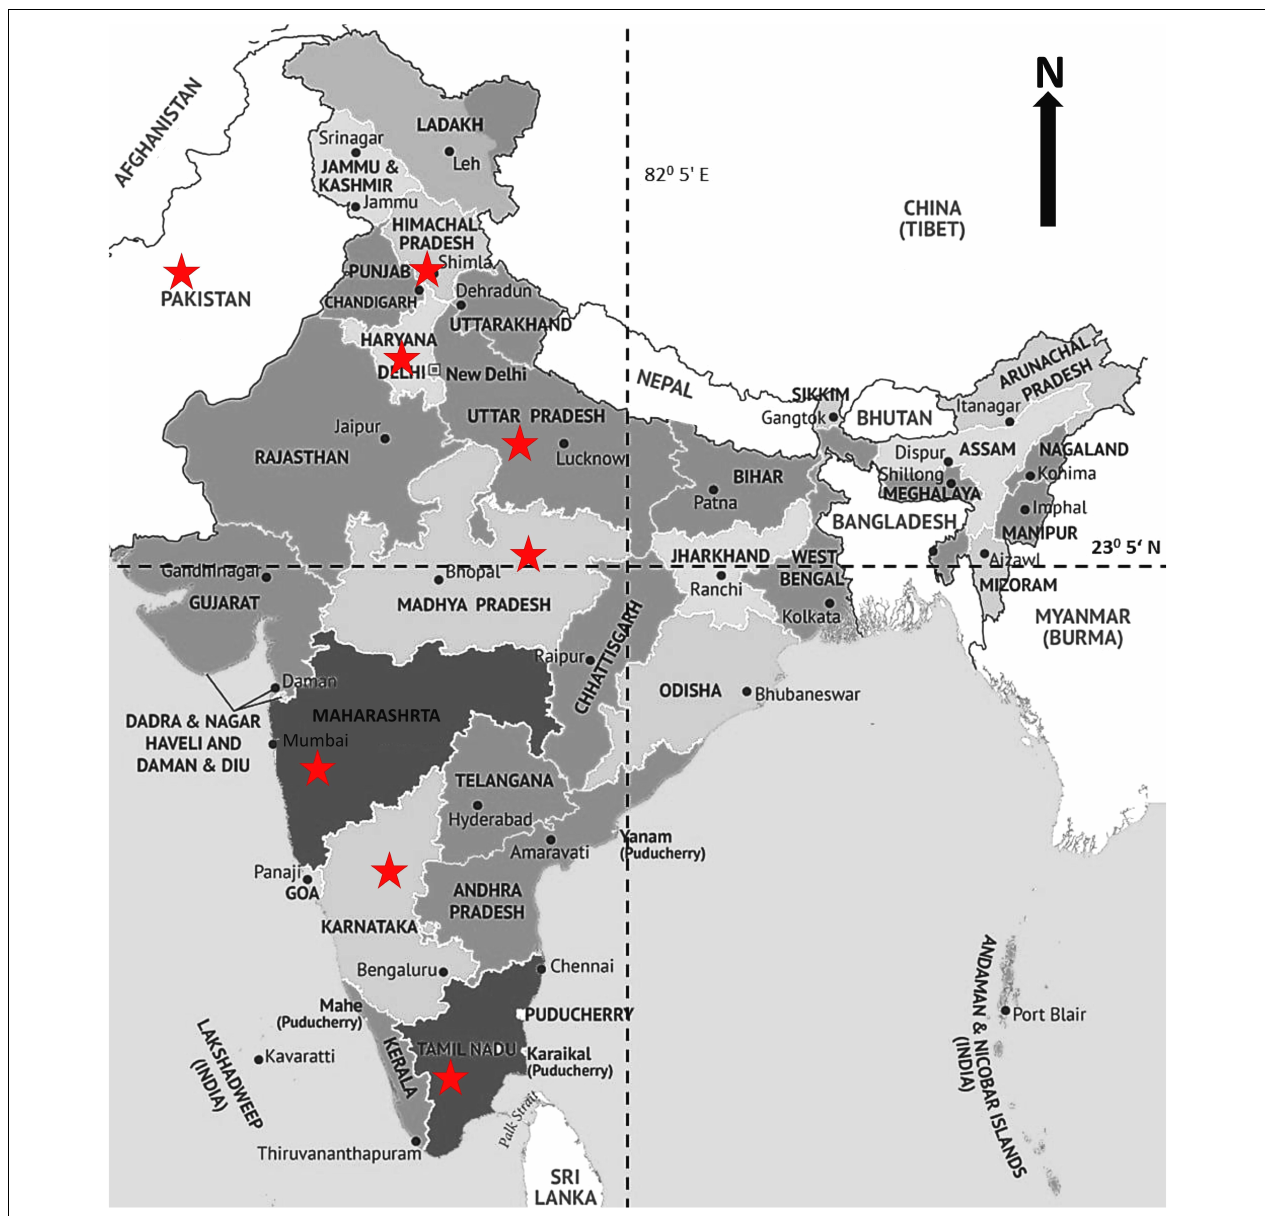
FIGURE 1 | Wheat growing areas of India showing the field locations (indicated by a star), where Puccinia graminis f. sp. tritici pathotypes were initially